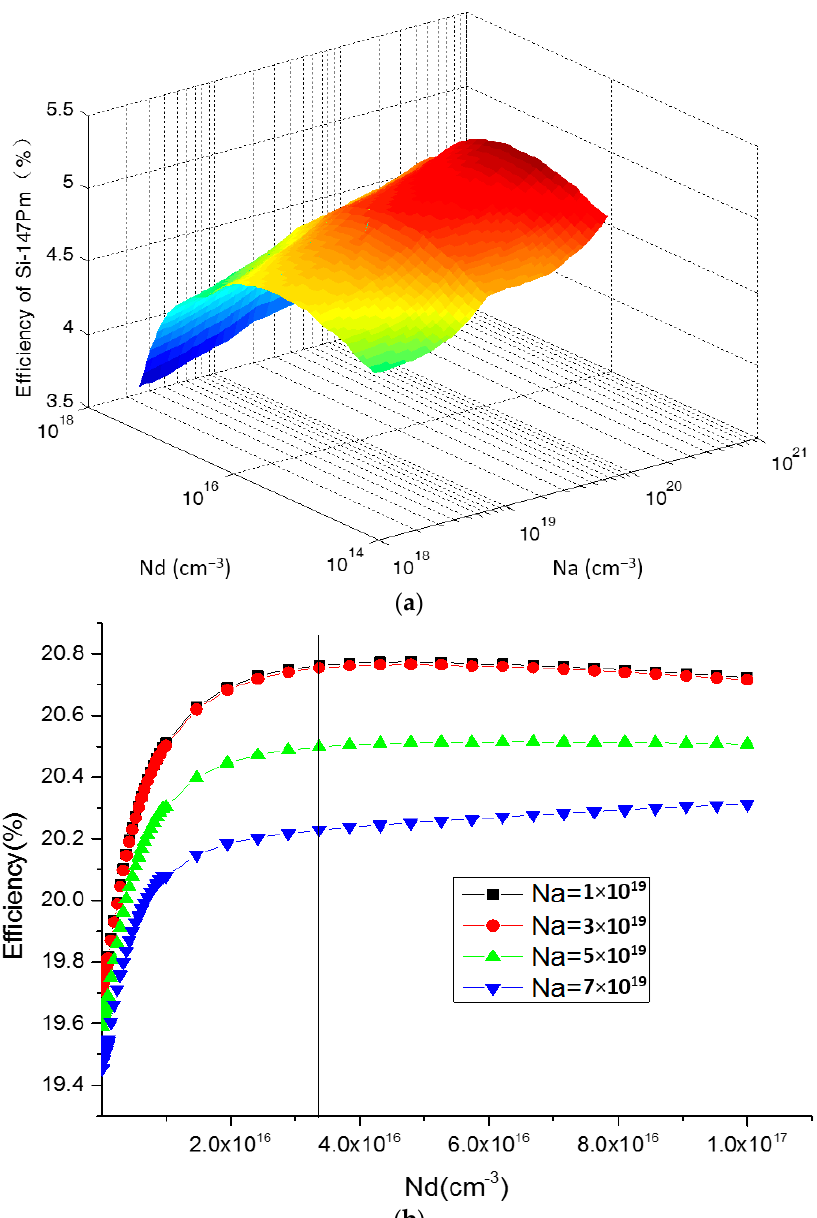
Figure 4. Relationship between the maximum conversion efficiency and doping concentration for the multi-source energy harvester. ( a ) Doping concentration parameters optimization simulated by MCNP (version 5, Radiation Safety Information Computational Center, Oak Ridge, TN, USA) for radioisotope energy harvesting; ( b ) Doping concentration parameters optimization simulated by PC1D (version 5.9, University of New South Wales, Sydney, Australia) for solar energy harvesting.